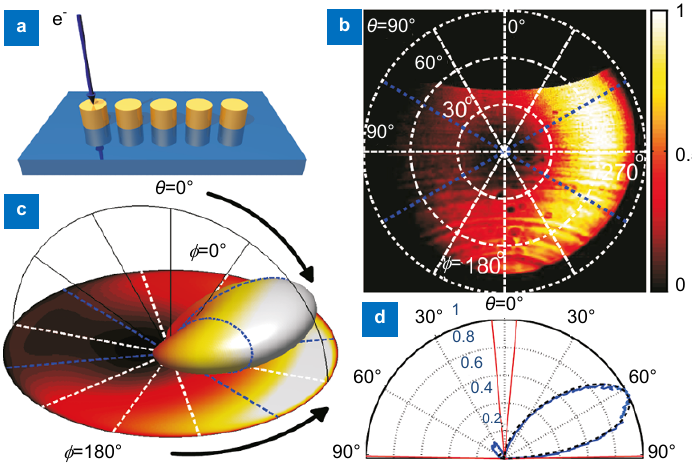
Fig. 10 | ( a ) Schematic of the excitation geometry. ( b ) CL emission intensity as a function of angle. ( c ) 3D representation of theoretical radiation pattern for this excitation position and wavelength, together with a projection onto a 2D grid. ( d ) Cross-cut through the angular data showing CL intensity as a function of θ (blue curve) together with theory (black dashed curve). Figure reproduced from ref. 75 , ACS